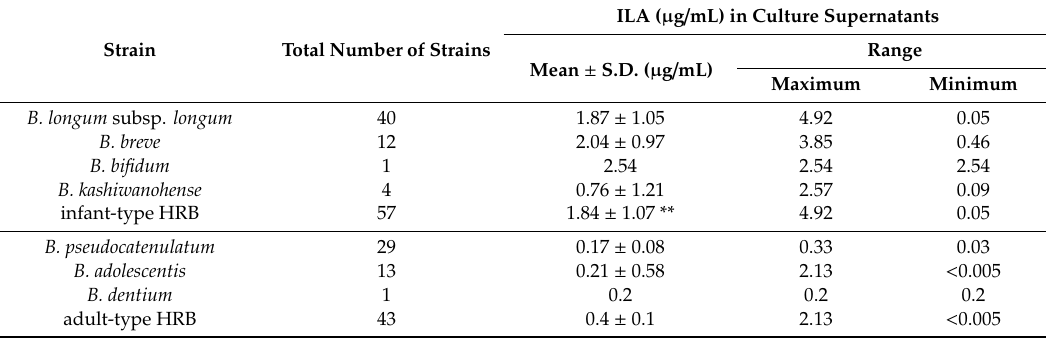
Table 2. Production of ILA by 100 Human-Residential Bifidobacteria (HRB)